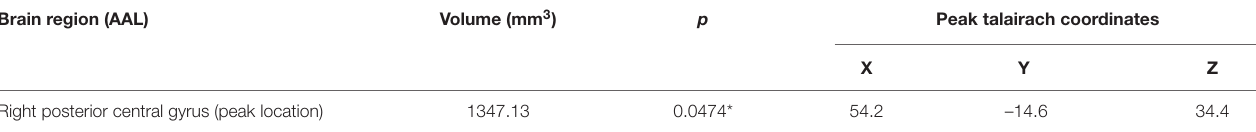
TABLE 2 | Regions with increased cortical thickness in AMD group compared with HC group.